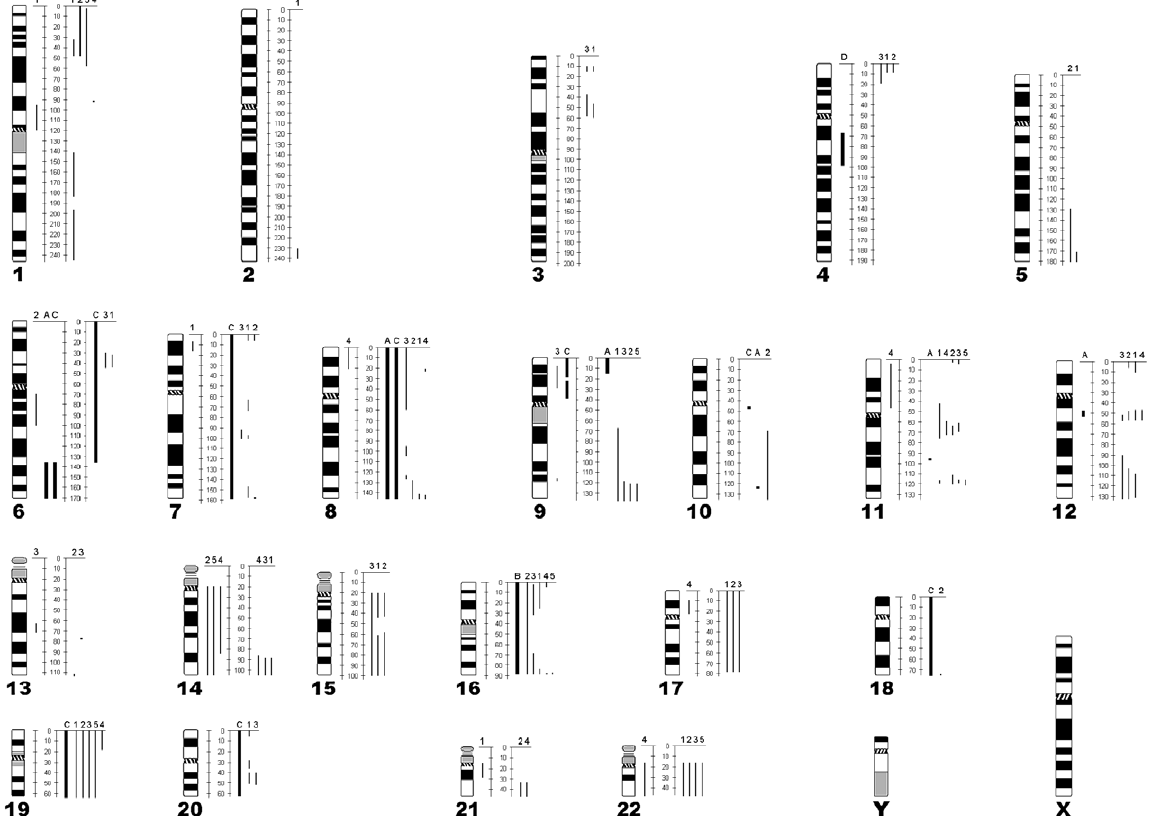
Fig. 5. Overview of all copy number alterations of 4 ACC-HGT (cases B, D, E and F) and 5 solid ACC (cases 1–5). To the right of the pictogram of each chromosome, a scale is placed expressing the number of megabasepairs (Mpb) counting from pter to qter. Copy number losses are presented as bars left to the Mbp-scale and copy number gains to the